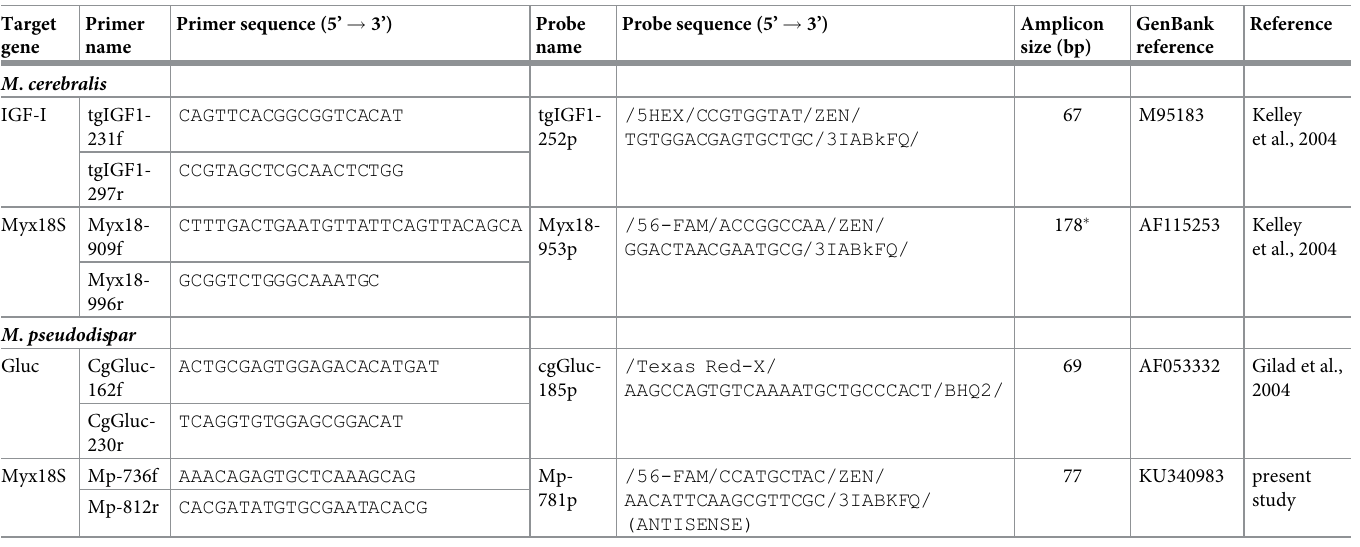
Table 1. Primers and probes used for Myxoboluscerebralis and M. pseudodispar -specific qPCR